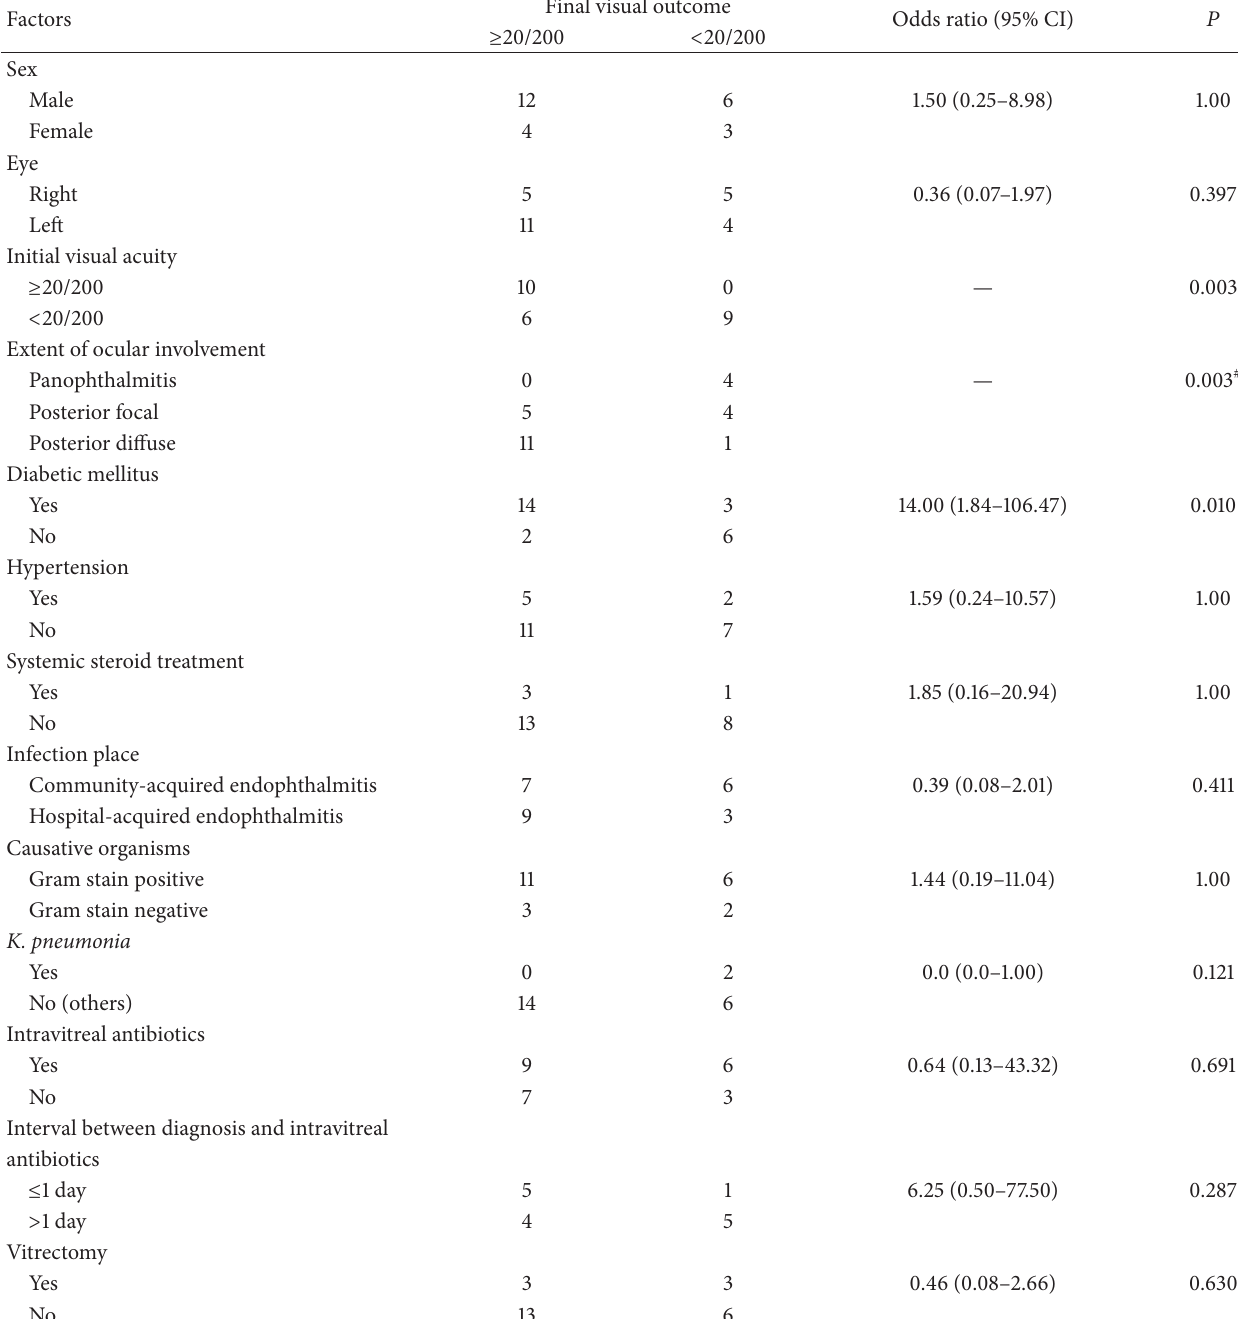
Table 4: Prognostic factors associated with good visual